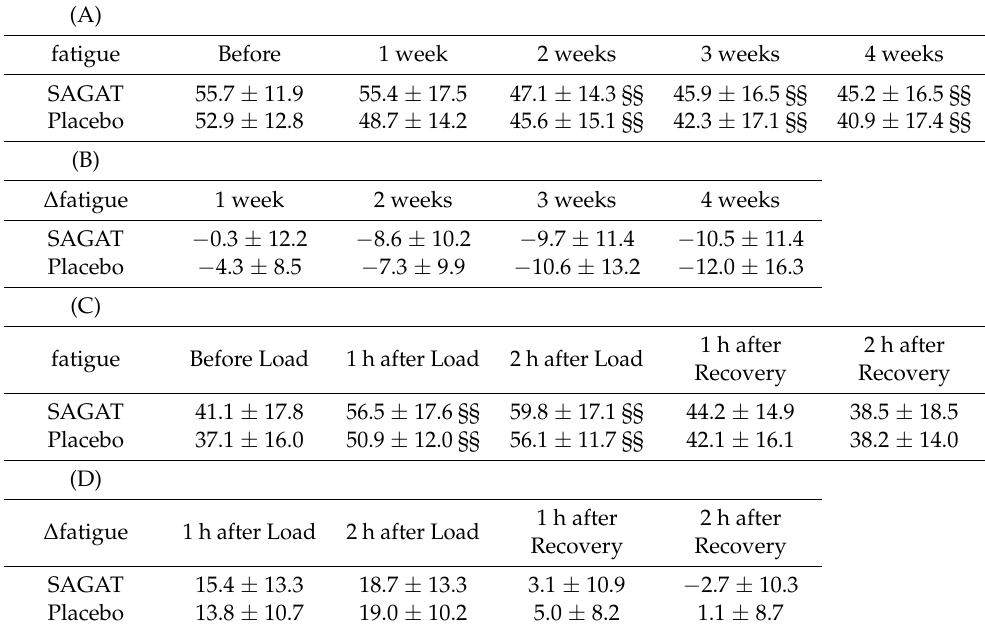
Table 2. VAS for